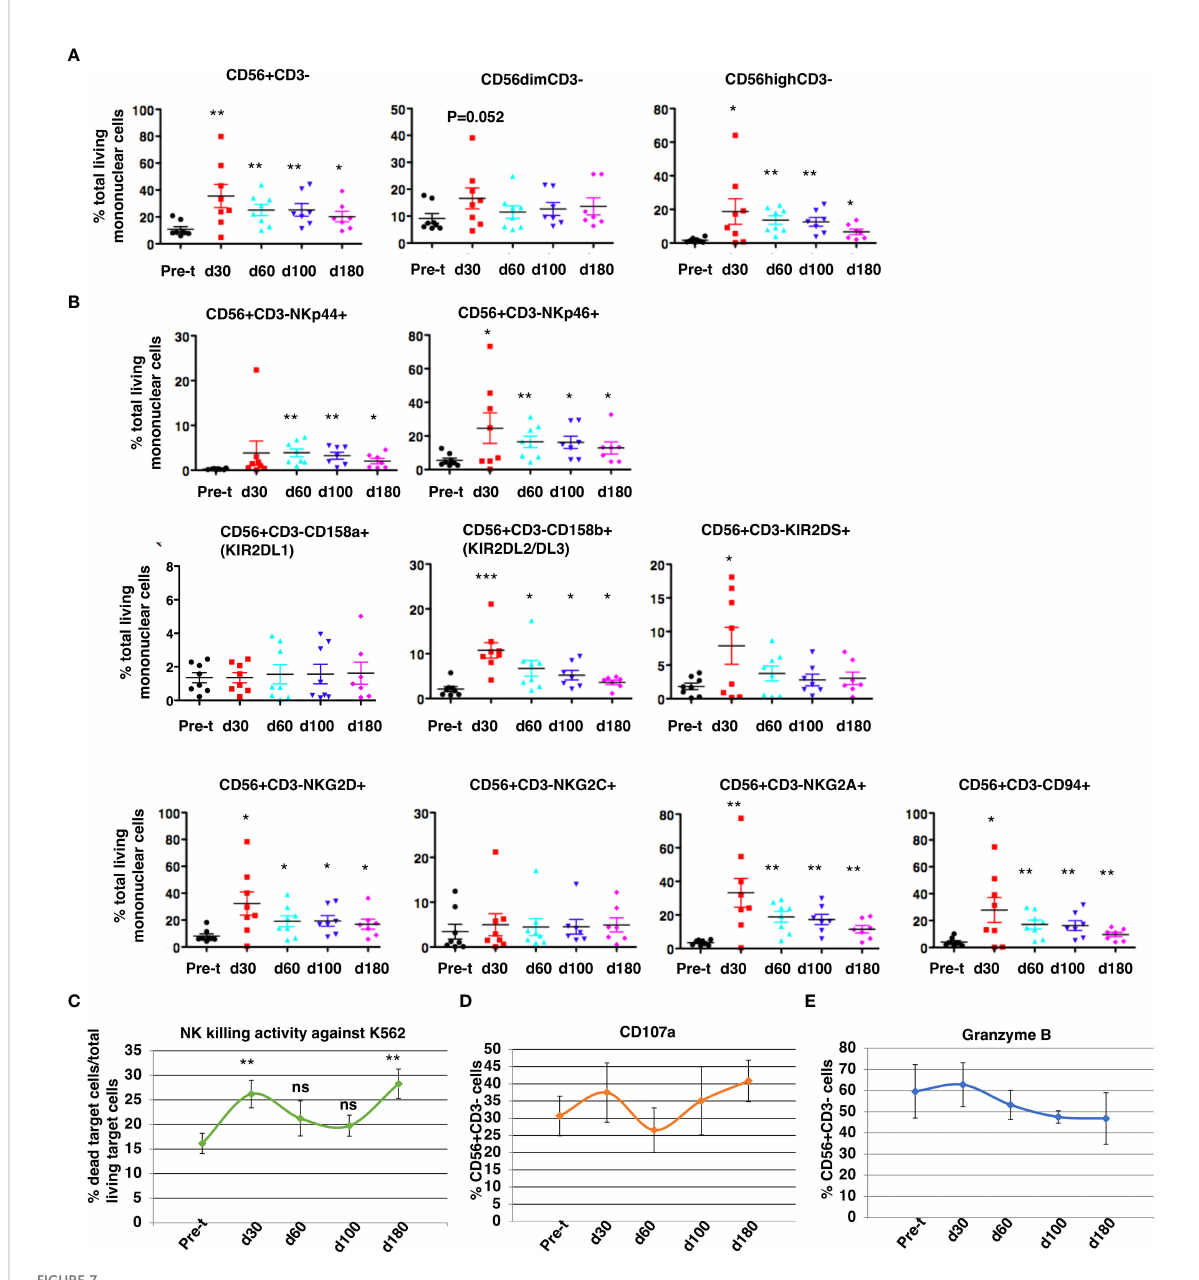
FIGURE 7 NK cell reconstitution. NK CD3 - /CD56 + cell reconstitution (A) , receptor expression (B) , NK cytotoxicity against K562 at a E:T=10:1 (C) , functional activation (CD107a) (D) , and protease expression (Granzyme B) (E) were characterized in the patients ’ peripheral blood from 30 to 180 days after HSCT. Pre-t, pre-transplant; d, day; *p<0.05; **p<0.01; ***p<0.001; ns, not signi fi cant; NK, natural killer; HSCT, hematopoietic stem cell